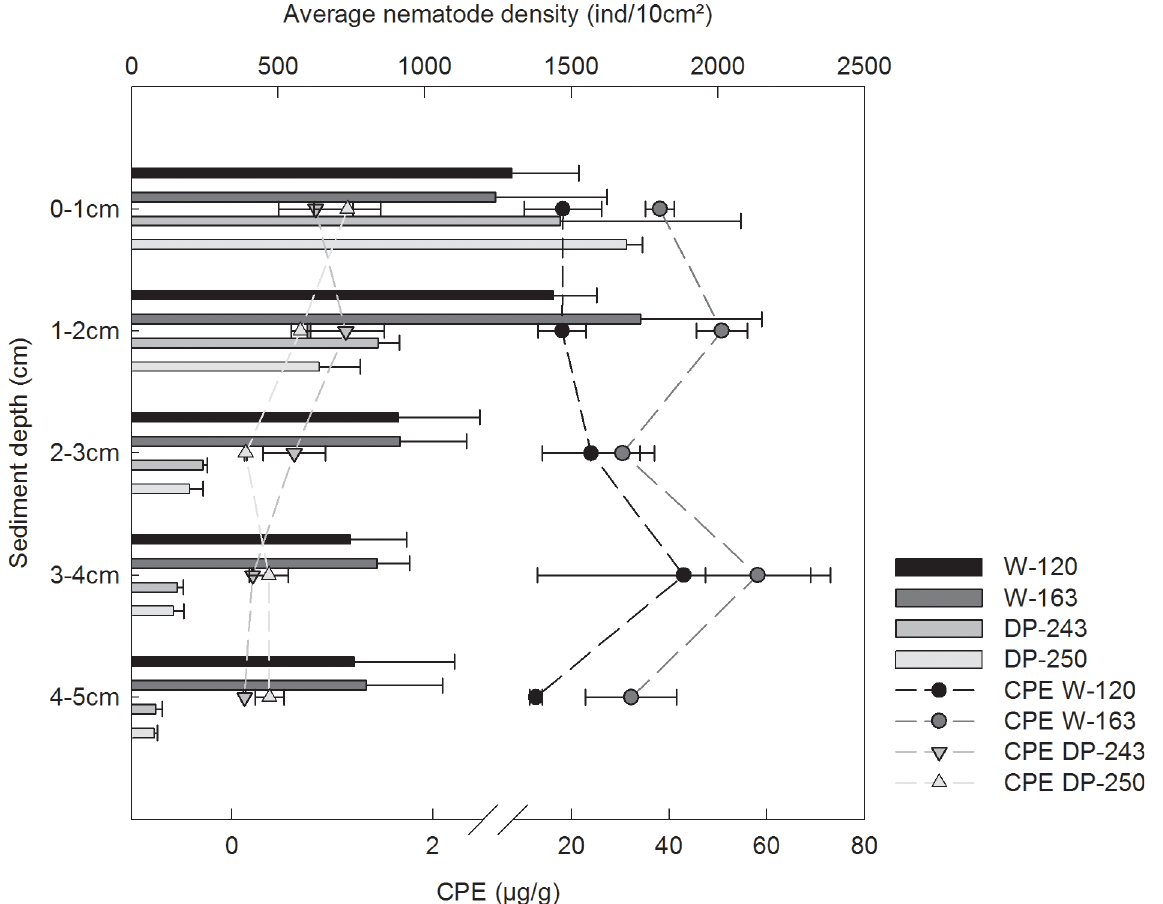
Fig 2. Vertical distribution of pigments and nematodes. Average CPE values ( μ g g -1 ; dots) and nematode densities (ind 10 cm -2 , bars) with their respective standard error in the sediment for all four stations (n =